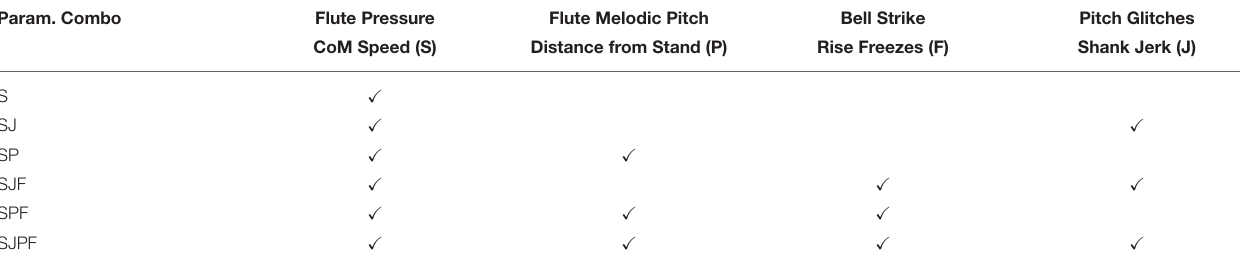
TABLE 3 | The six parameter combinations used to generate the sound sequences. Param.